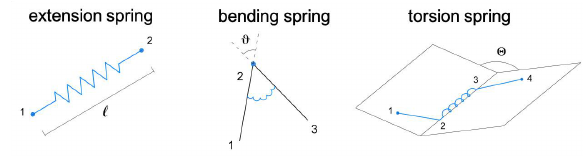
Figure 3: Side (a) and top view (b) of the modified T3. Top view of the classical T3 (c).